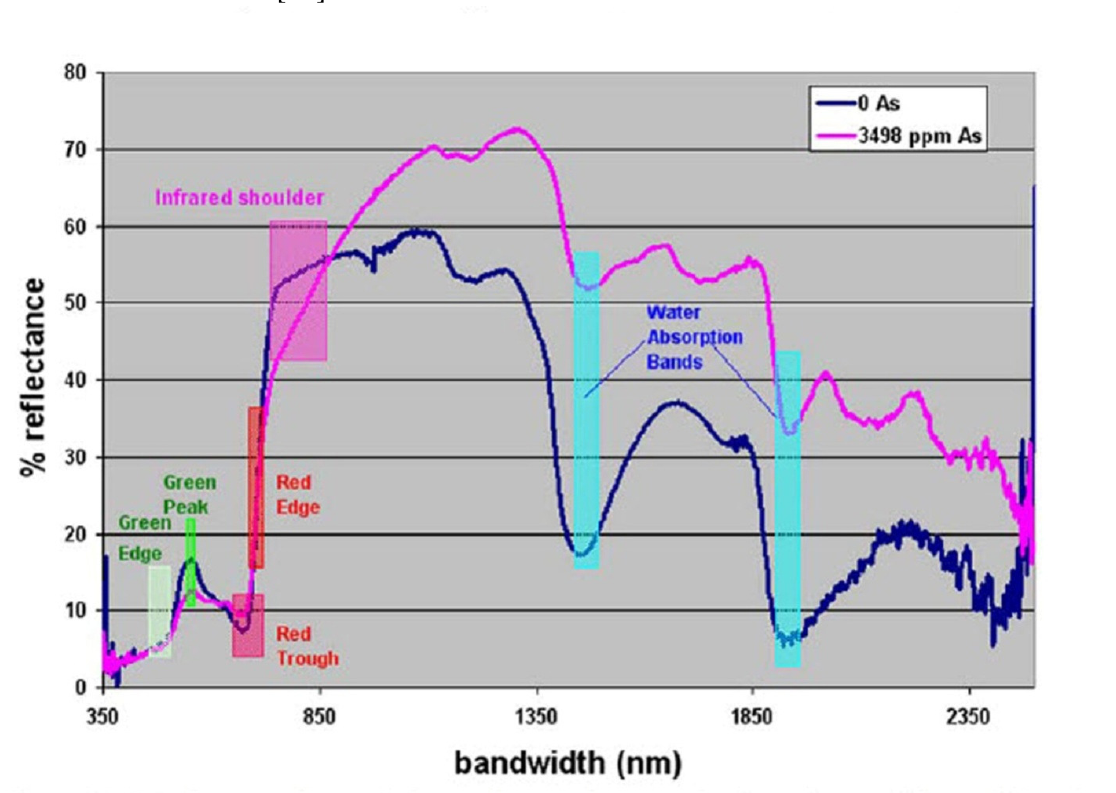
Figure 11. Spectra differences in plant reflectance as a result of Arsenic stress in grasses. From Slonecker 2007